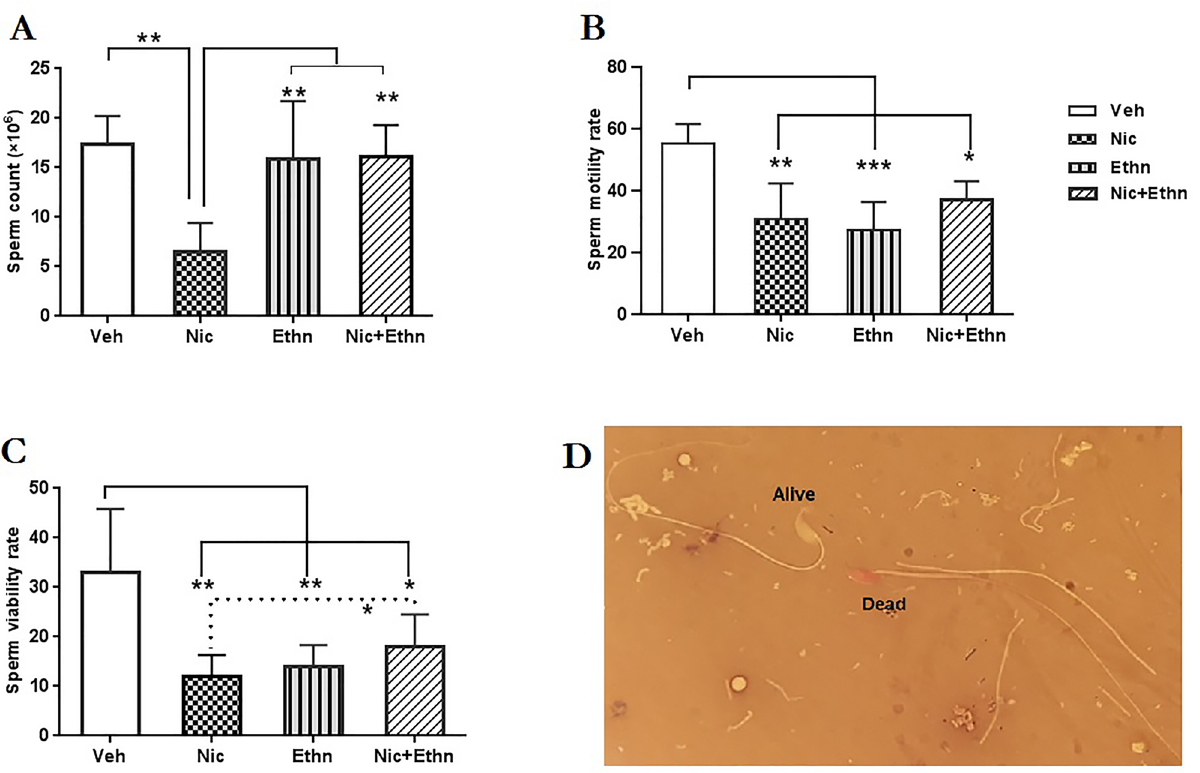
Figure 2. The effect of in utero and lactational exposure to nicotine and ethanol, either alone or concurrently, on sperm parameters of adult offspring. Sperm parameters included of sperm count ( A ), sperm motility ( B ) and sperm vitality ( C ). ( D ) Stained sperm with eosin Y/ nigrosine to determine viability, alive sperm is colorless and dead sperm is pink. *, ** and *** indicate p ≤ 0.05, p ≤ 0.01 and p ≤ 0. Semi‑quantitative analysis of spermatogenesis by Johnsen’s score. The result of Johnsen’s score evaluation showed that exposure to either nicotine, ethanol or their co-exposure during in utero development and lactation periods can change the Johnsen’s score of adult offspring compared to the Veh group (F 3,18 = 19.38, p = 0.000). This score decreased in the Nic (p = 0.000), Ethn (p = 0.002) and Nic + Ethn (p = 0.002) groups, respectively relative to the Vehicle’s score. However, this parameter was significantly high in the nicotine-exposed pups when compared to the ethanol-exposed pups alone (p = 0.03) and combinations (p = 0.02). Sperm quantitative analysis. The data analysis showed that the administration of either alcohol, nicotine or their co-administration during pregnancy and lactation had main effects on sperm number (F 3, 18 = 7.57, p = 0.003), motility (F 3, 18 = 8.54, p = 0.002) and viability (Chi square = 12.58, df = 3, p = 0.006). Sperm number. As shown in the Fig. 2A, the sperm number significantly reduced in the Nic group (p = 0.005) when compared to that of the Veh group. However, the sperm number of mice that exposed to nicotine during prenatal and postnatal periods showed a significant difference in compared to those of exposed to either ethanol (p = 0.01) or their combination (p = 0.009) (Fig. 2A). Sperm motility. The mean percentage of sperm motility decreased in all pups that exposed to either nicotine (p = 0.004), ethanol (p = 0.001) alone or concurrently (p = 0.033) when compared to those was observed in the Veh group (Fig. 2B).